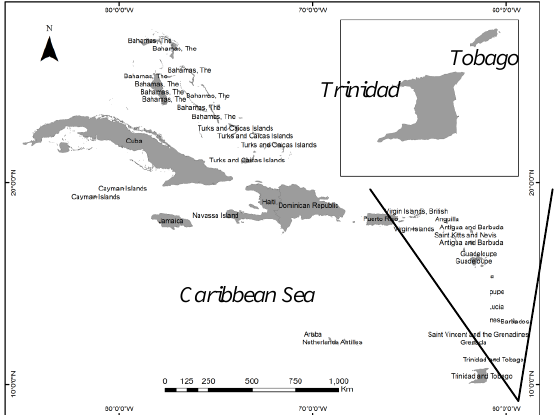
Figure 1. Location of Trinidad and Tobago in the